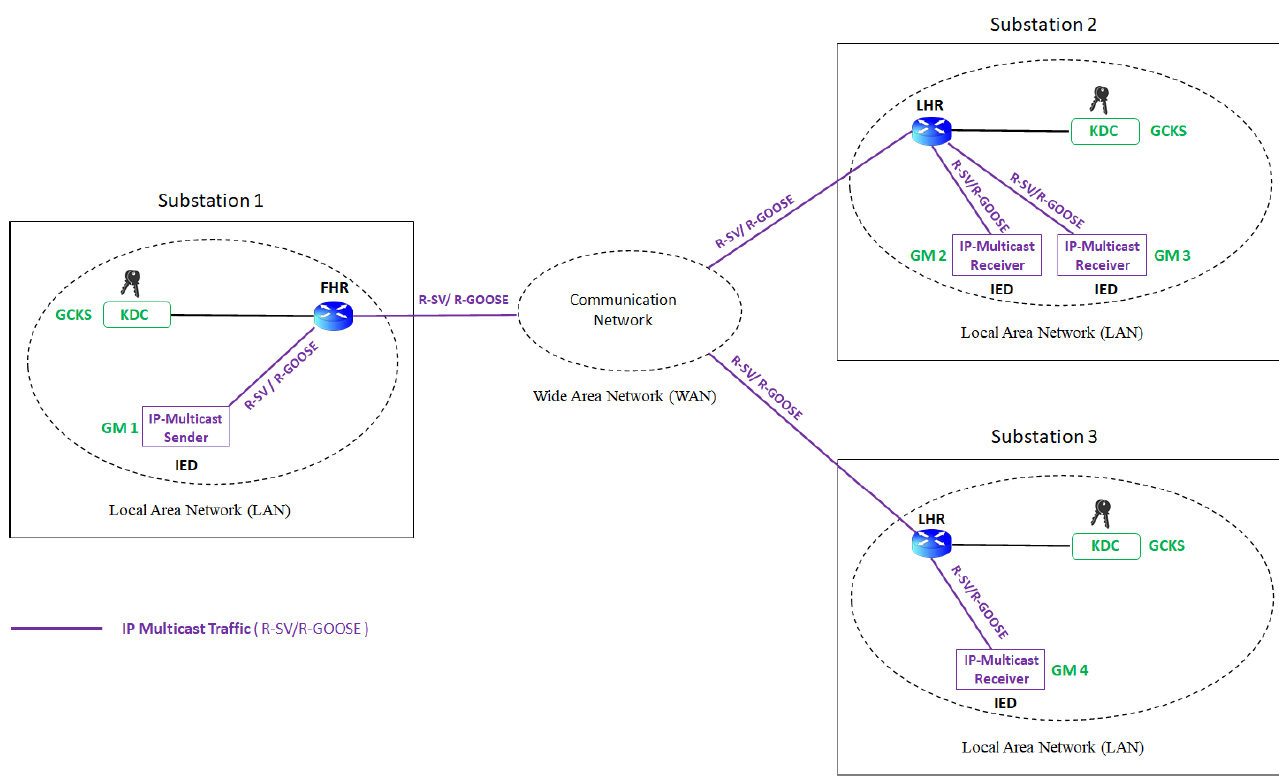
Figure 7. GDOI components (GCKS and GMs) for securing R-SV/R-GOOSE messages in multicast communication from Substation 1 to Substation 2 and 3. Table 4. Description of GDOI mechanism and keying materials between GCKS and